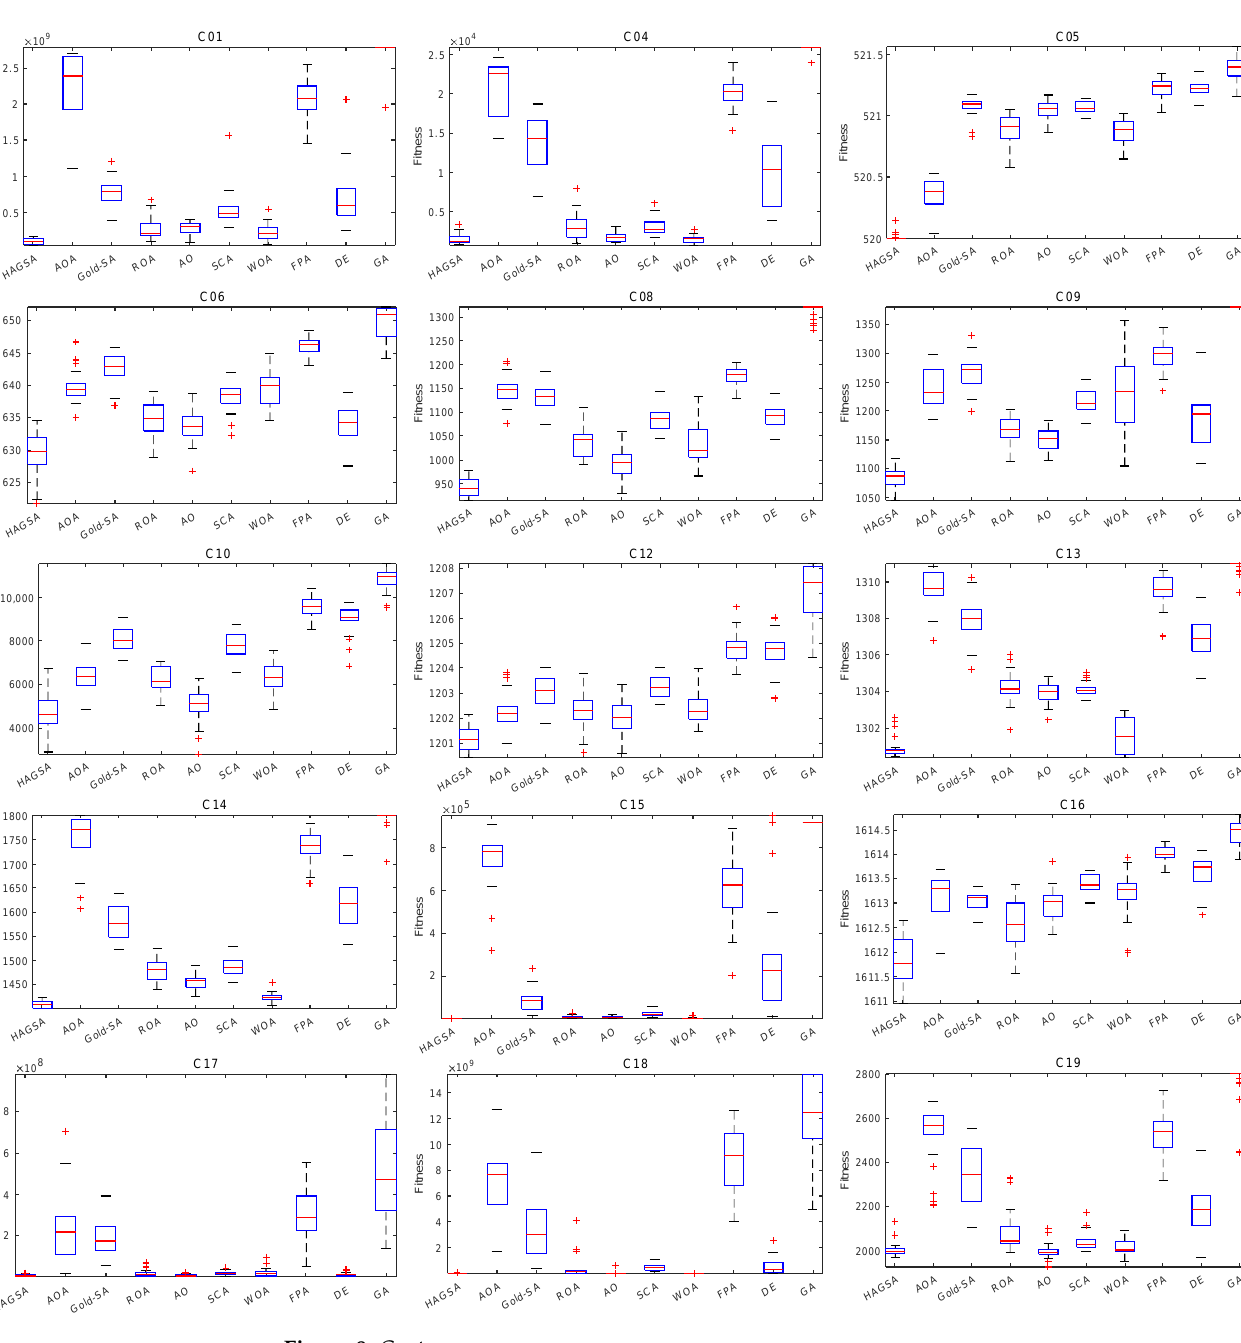
Figure 8. Boxplot behavior of algorithms on some functions. 4.5. Convergence Behavior Analysis